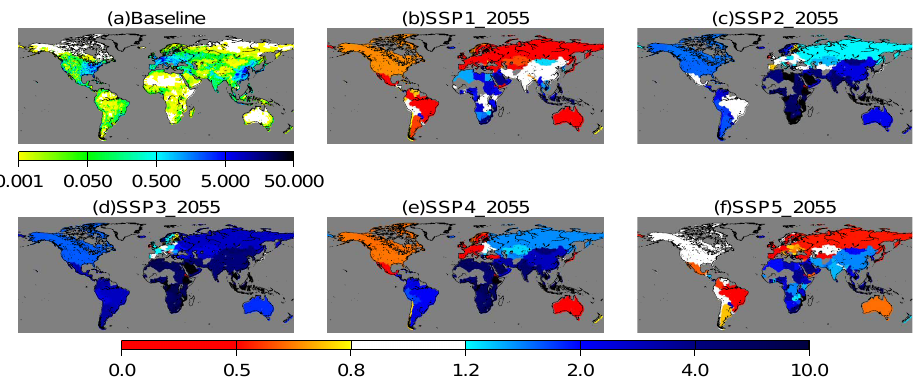
Fig. 11. Global distribution of withdrawal-based potential industrial water demand. (a) Baseline year (circa 2000) (m 3 s − 1 ) , (b–f) Change (ratio) from the baseline year for SSP1–5 in 2055.